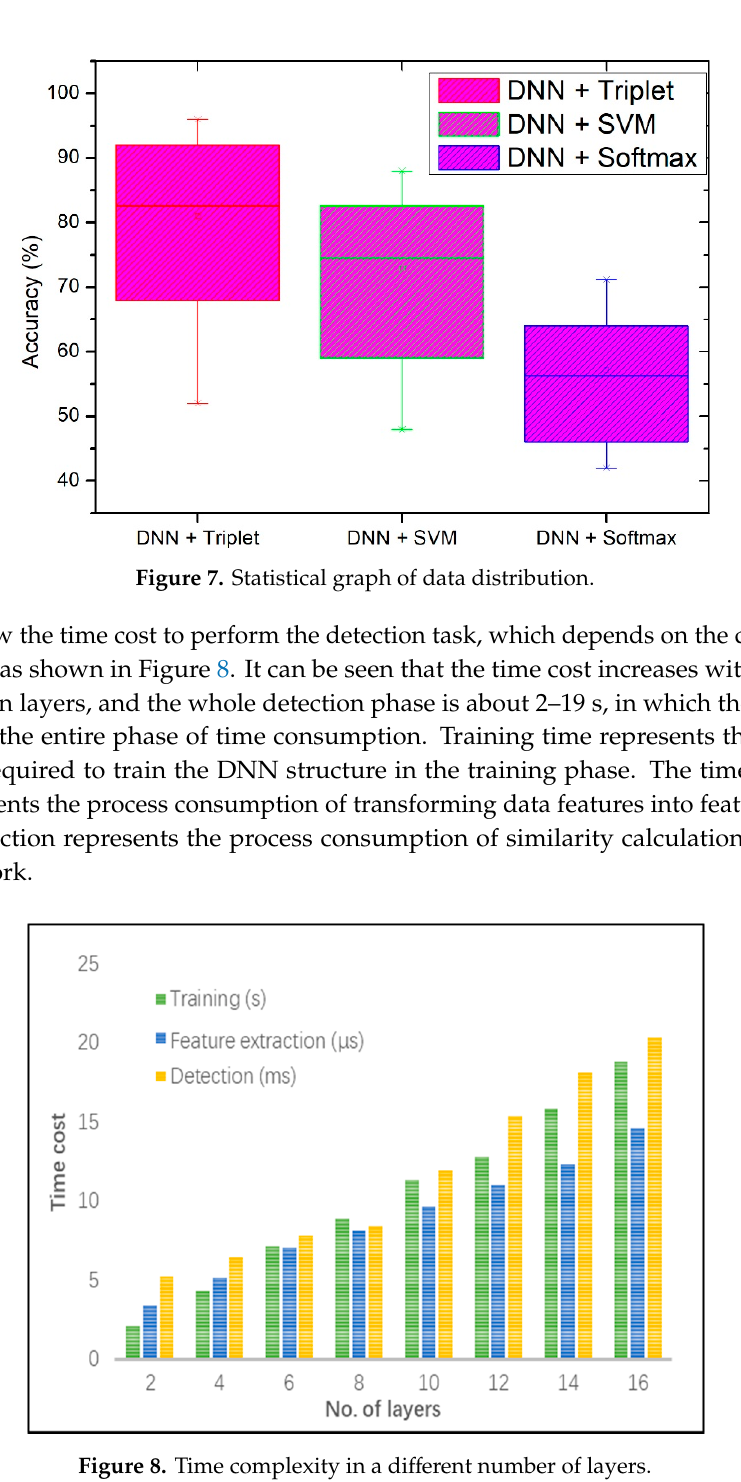
Figure 8. Time complexity in a different number of layers.